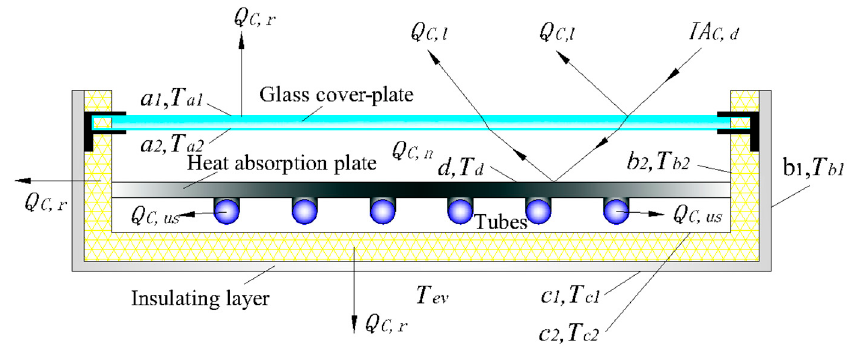
Figure 4. Schematic of the energy conservation of a flat-plate solar collector.